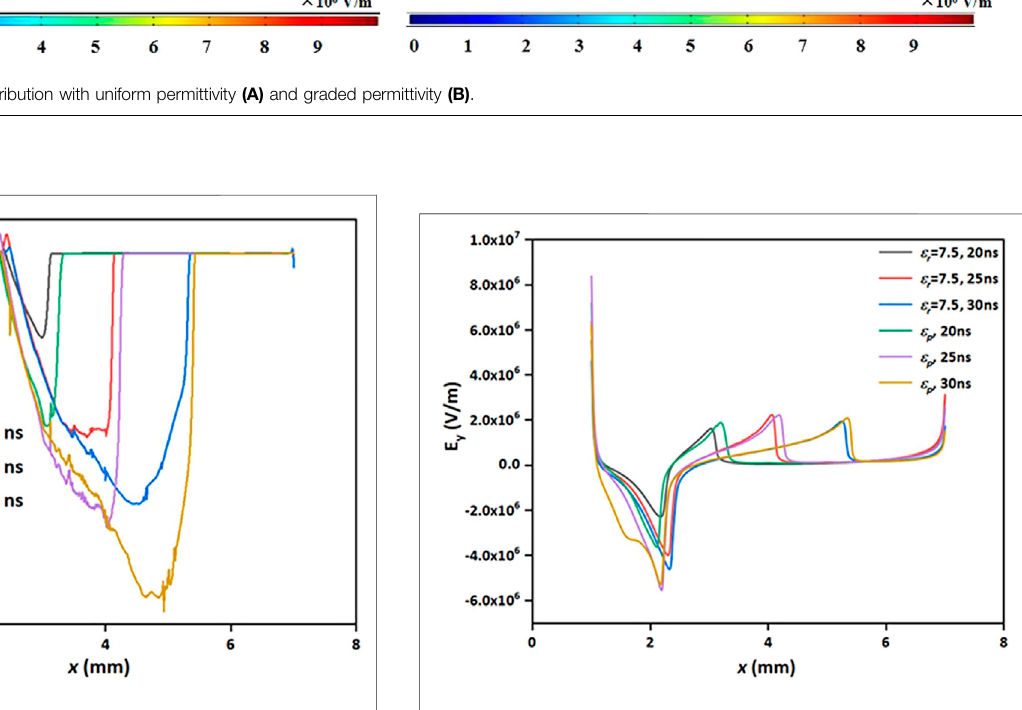
FIGURE 6 | Surface charge density. FIGURE 7 | E y